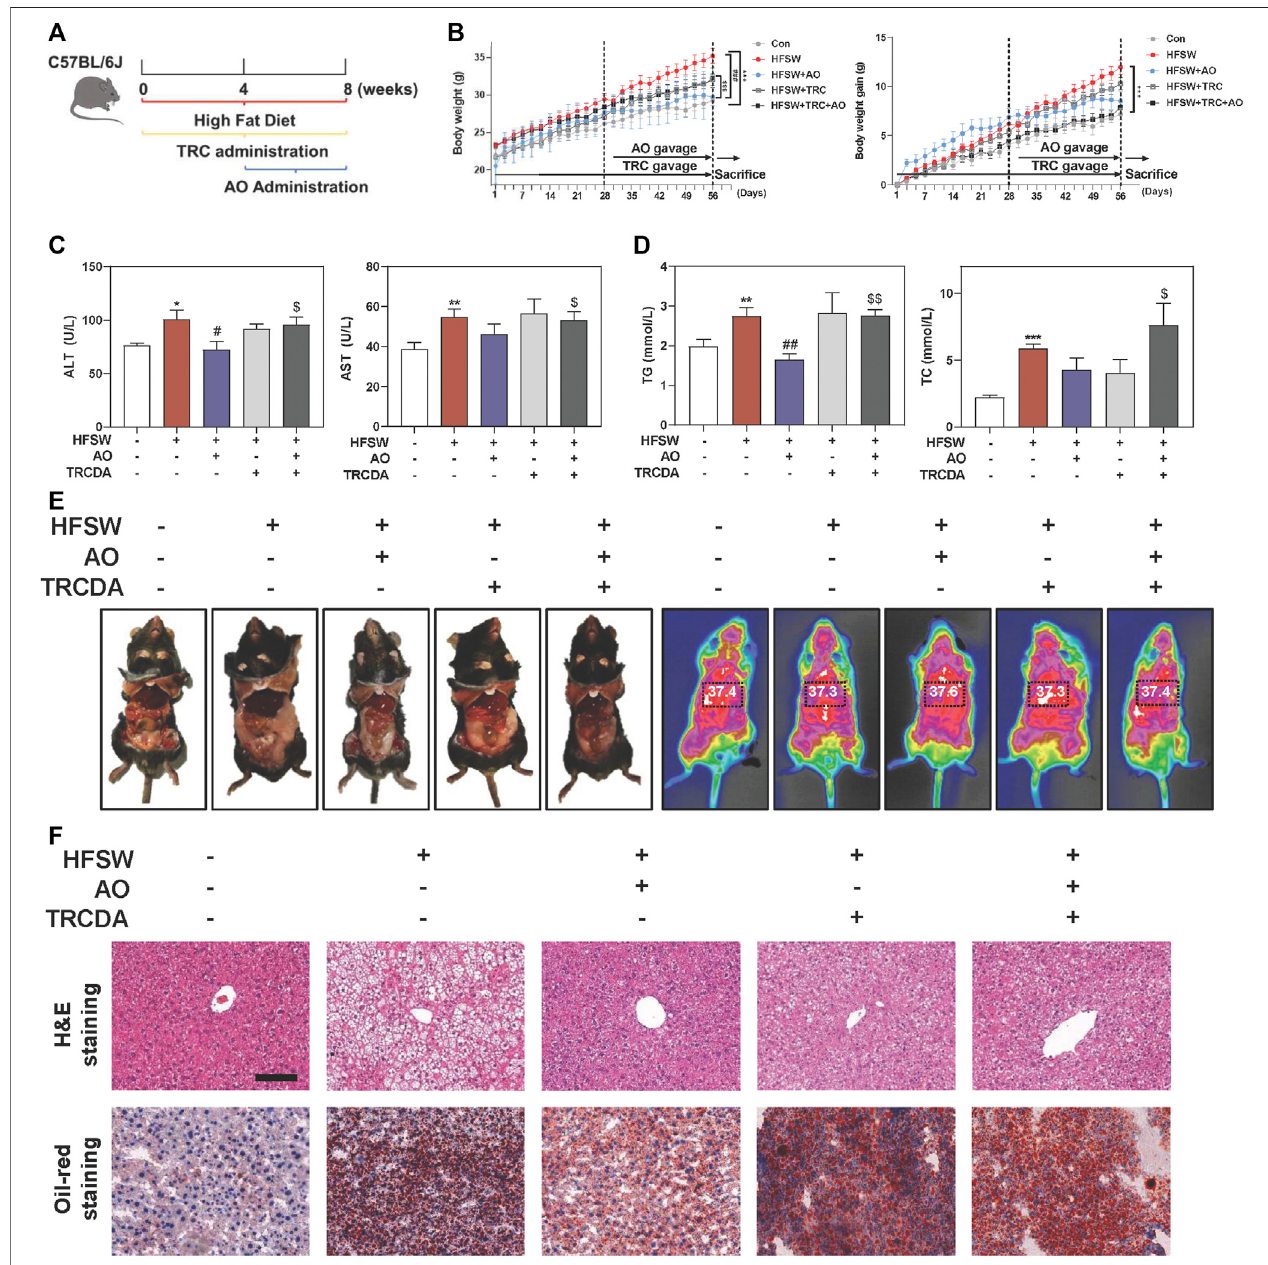
FIGURE6| InhibitionofACOX1suppressedAO-mediatedprotectiveeffectsagainstNAFLD.MicewerefedchowdietorHFSWdietfor8weeks,andadministered withTRCDA(1 mg/kg)duringthewhole8weeksofHFSWdietfollowedbyadministrationwithAO(10 mg/kg)fromWeek5 (A) Schematicdiagramof invivo experimental design (B) Body weight and Body weight gain (C) Serum ALT and AST levels (D) Serum TG and TC levels (E) Representative images of epididymal fat and thoracoabdominal temperature (F) Representative images of H&E and oil red O staining. Scale bar (cid:1) 100 μ m. Statistical signi fi cance: * p < 0.05, ** p < 0.01, *** p < 0.001, compared with control group; # p < 0.05, ## p < 0.01, compared with HFSW group; $ p < 0.05, $$ p < 0.01, compared with HFSW + AO group (n (cid:1)